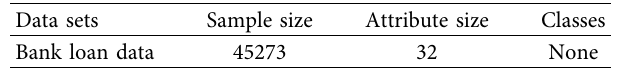
Table 1: Attribute characteristics of experimental data